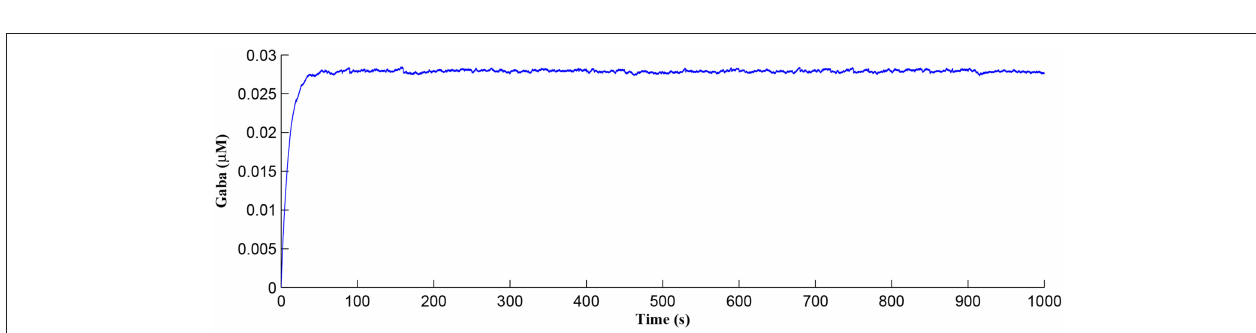
FIGURE 5 | Time dependant synaptic weight update governed by the STDP learning rule. When the plasticity window is open, learning commences, the synaptic weight begins to potentiate and after a period of learning the window shuts off and the synaptic weight stabilizes.